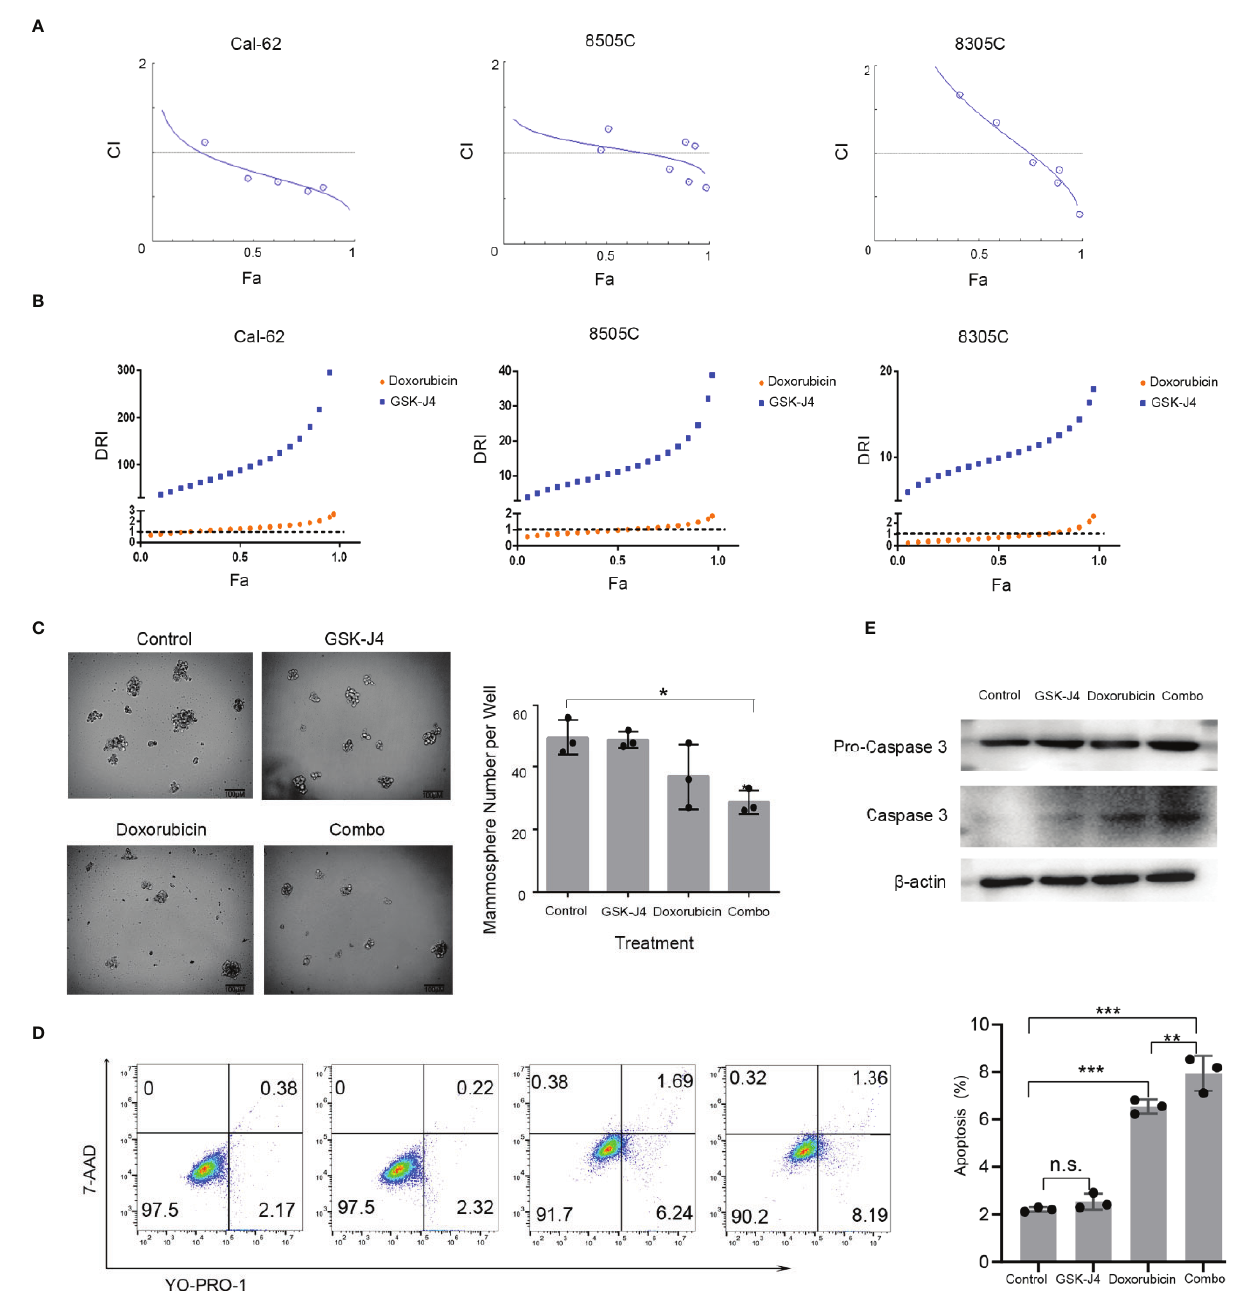
FIGURE 2 | The Effect of GSK-J4 Combined With Doxorubicin. Synergistic curves of Cal-62, 8505C, and 8305C cell lines treated with GSK-J4 and doxorubicin (A) DRI of Cal-62, 8505C, and 8305C cell lines treated with GSK-J4 and doxorubicin (B) The effect of GSK-J4 combined with doxorubicin on the sphere-forming ability (C) of the Cal-62 cell line. Scale bar, 100 m M. YO-PRO-1/7-AAD staining show the effect of GSK-J4 combined with doxorubicin on cell apoptosis of the Cal-62 cell line (D) , Western blot showed the caspase 3 and Pro-caspase 3 with the treatment of effect of GSK-J4 combined with doxorubicin (E) (DOX: GSK-J4 = 0.156:0.078 m M). DRI, Dose reduction index. n.s., no statistical difference. *, p < 0.05, **, p < 0.01, ***, p <